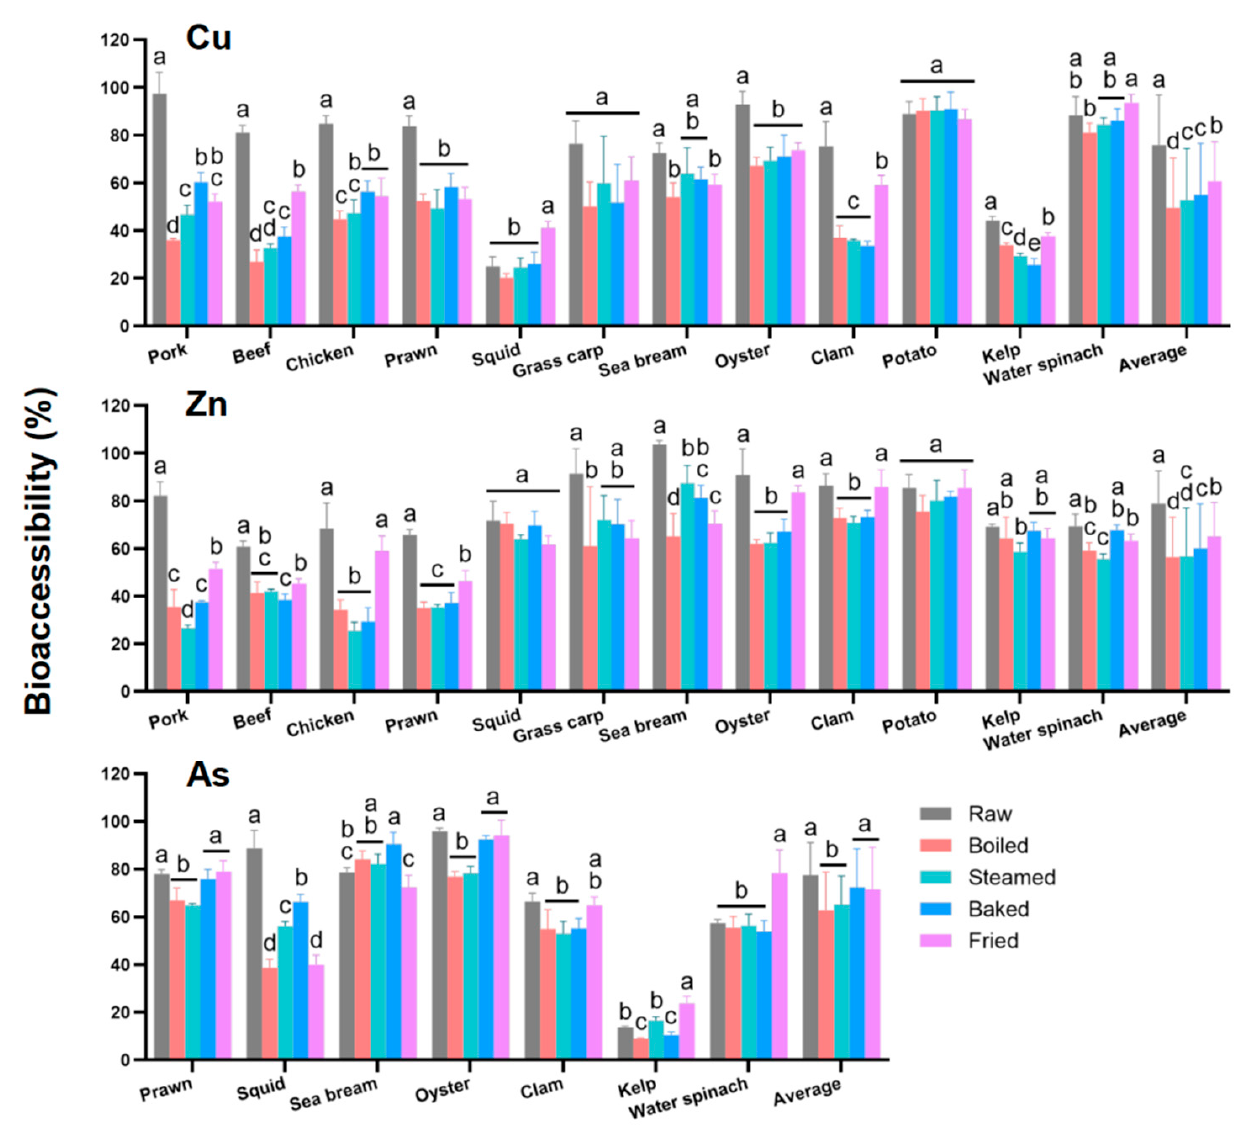
Figure 4. The bioaccessibility of Cu, Zn, and As in food ingredients. The kelp is not considered when calculating the average bioaccessibility of As due to its low value. Data are expressed as means ± SD ( n = 3). Di ff erent le tt ers (a, b, c, d) represent signi fi cant di ff erences among treatments ( p < 0.05).